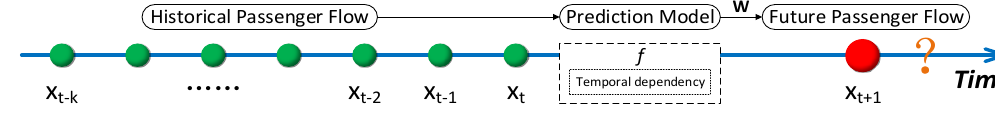
Figure 1. Problem definition of short-term passenger flow prediction.